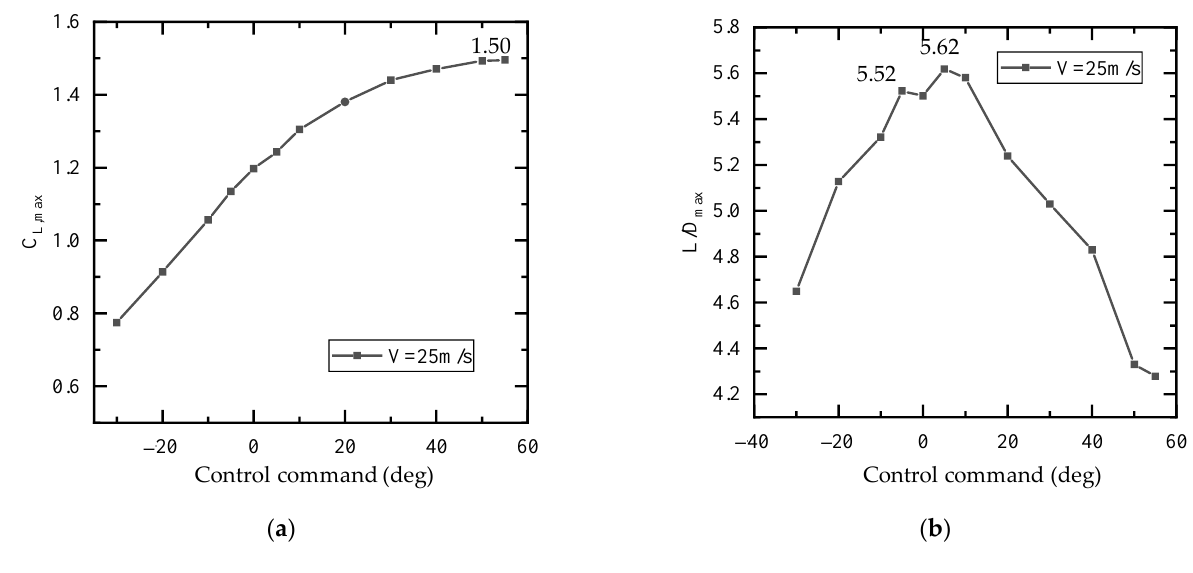
Figure 20. Maximum lift coefficient and maximum lift-to-drag ratio under different actuation inputs. ( a ) Maximum lift. ( b ) Maximum lift-to-drag ratio.